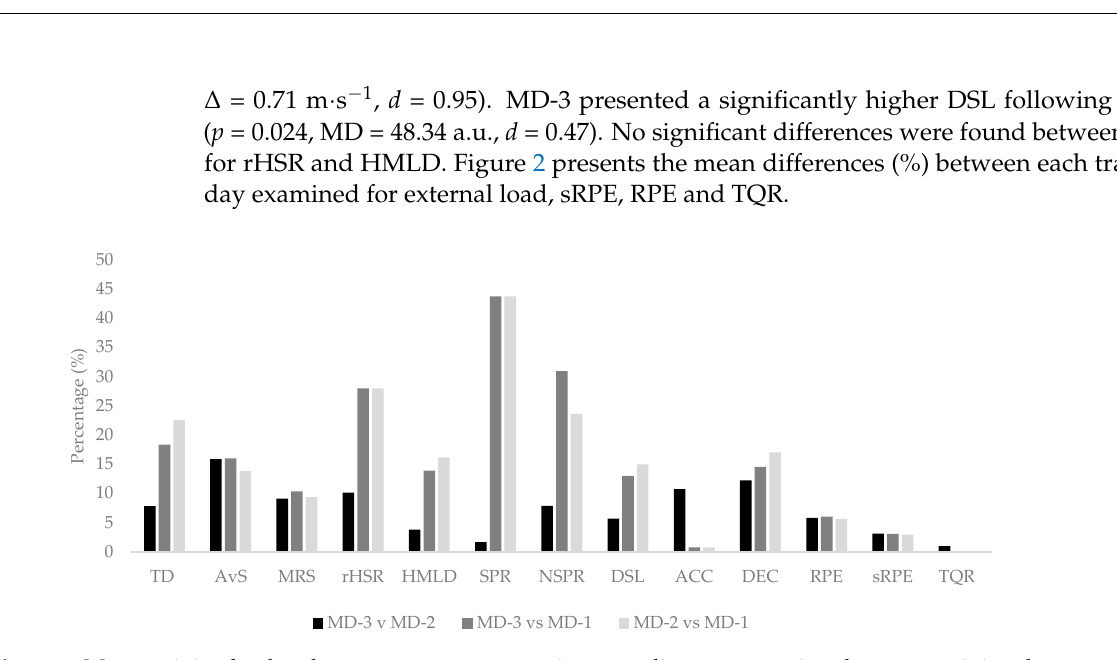
Figure 2. Mean training load and recovery status per session according to comparison between training days.